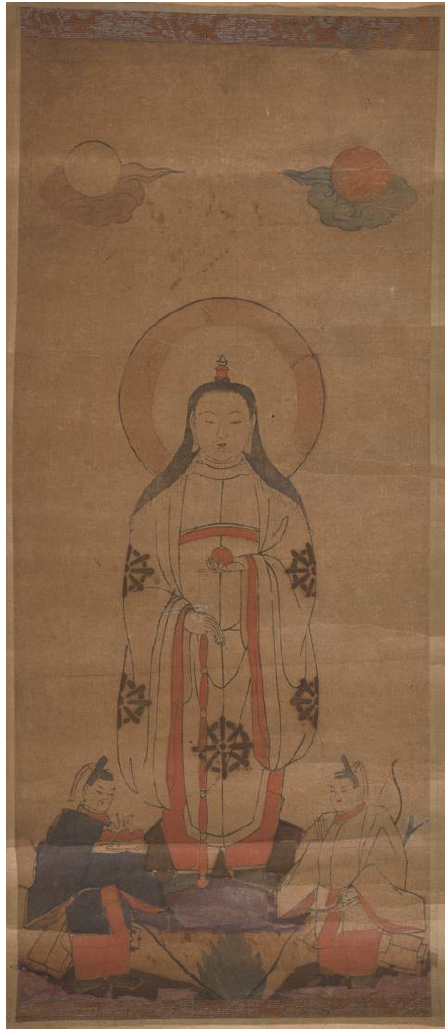
Figure 6. Sanja takusen , Edo period, hanging scroll, ink and colors on paper, 54.6 × 23.5 cm. Author’s